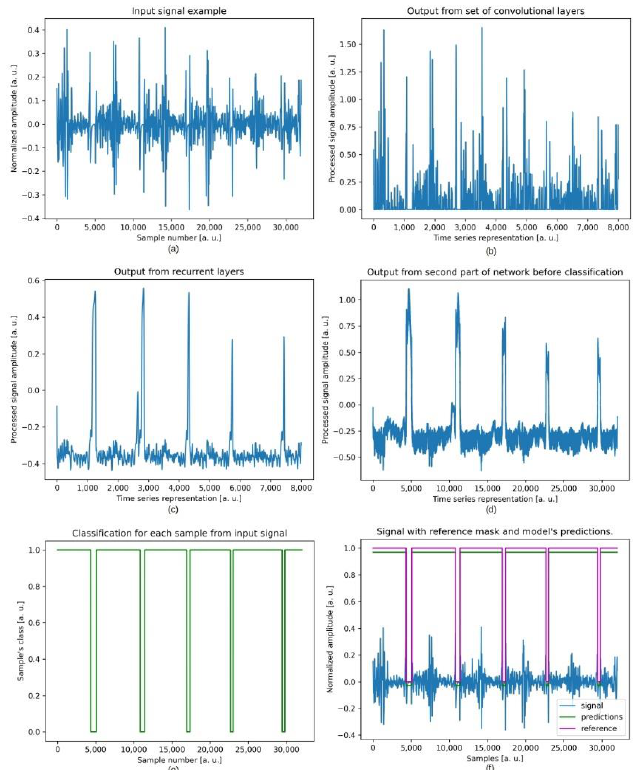
Figure 7. Collection of plots representing output examples from the intermediate steps of our model. ( a ) the original signal (input); ( b ) the signal representation (an arbitrarily chosen set of features) after